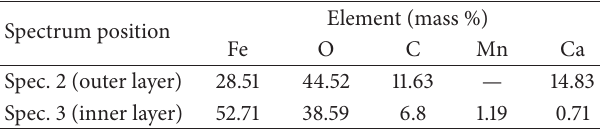
Figure 4: Corrosion rate of clubbed X80 steel specimens in acidic red soil for 5 years. Table 2: Composition of corrosion product (Figure 5(a)) on X80 steel in red soil for 24